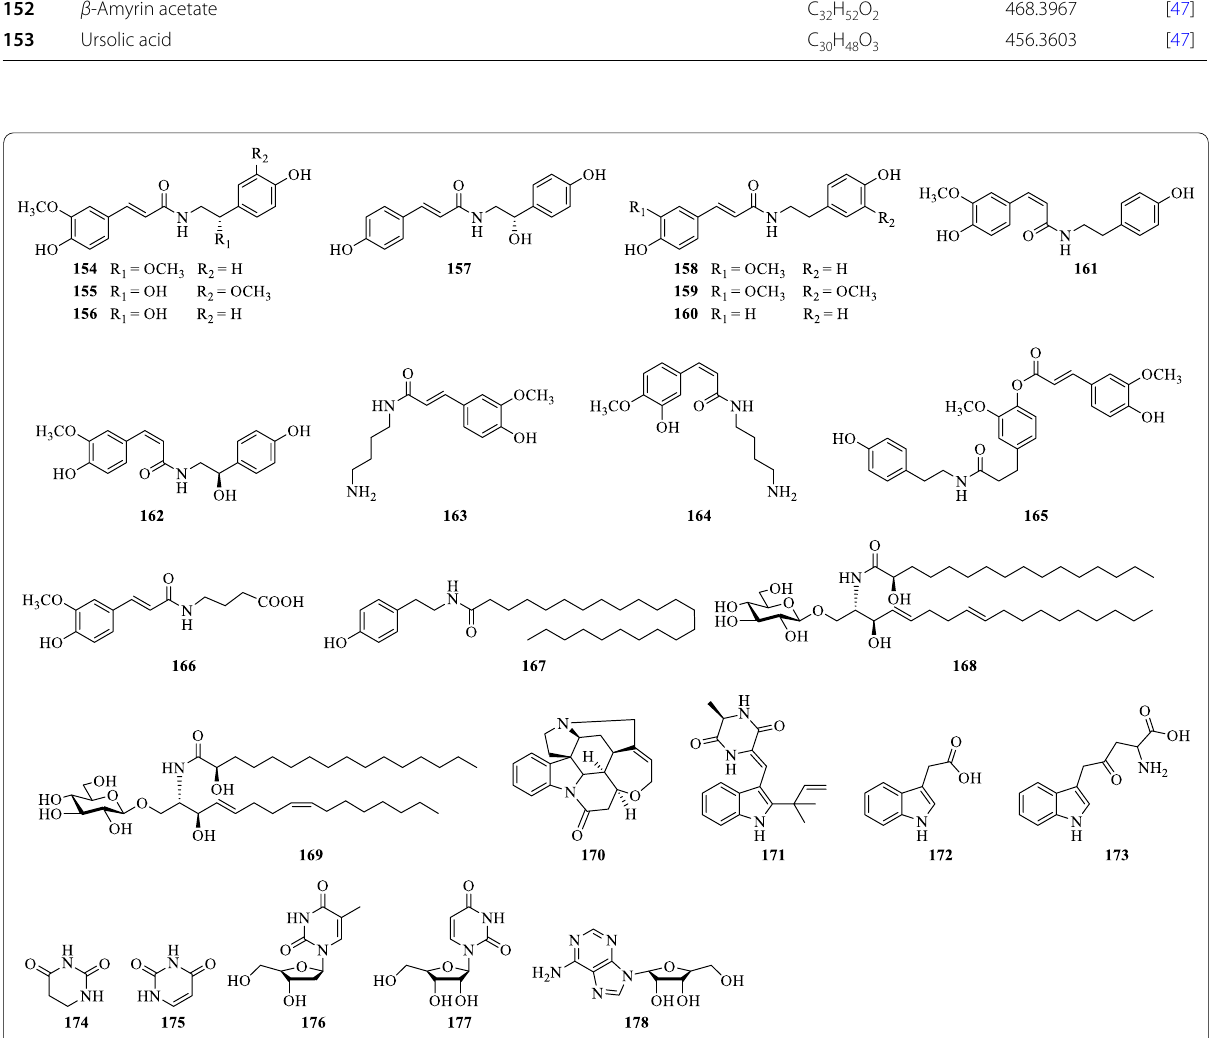
Fig. 13 Chemical structures of nitrogenous compounds from S.